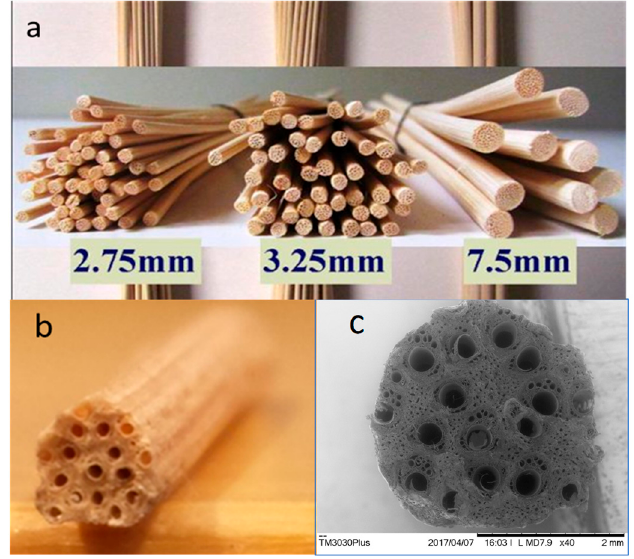
Figure 1. Cross-section of rattan materials: ( a ) rattans with different outer diameters (2.75 mm to 7.5 mm); ( b ) tested rattan (outer diameter, d o = 3.25 × 10 − 3 m); ( c ) SEM image.